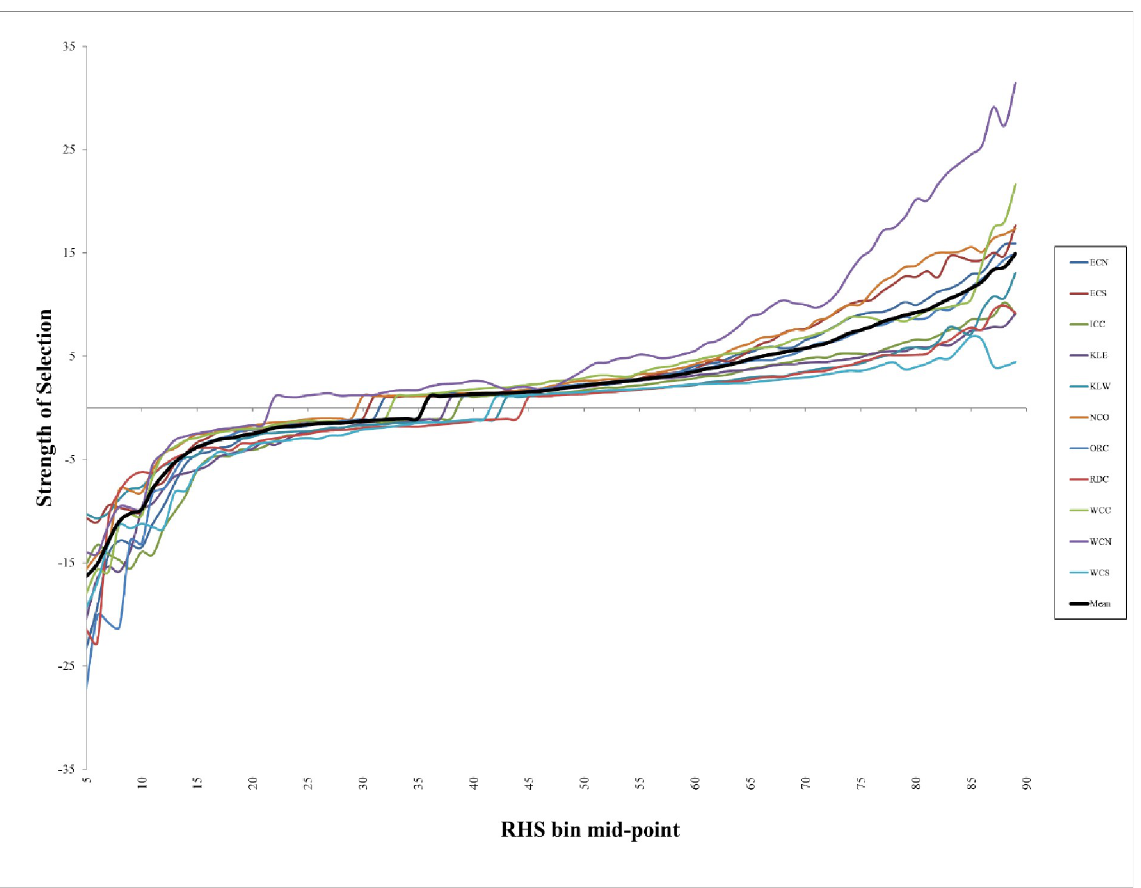
Fig 7. Northern Spotted Owl strength of selection (SOS) by relative habitat suitability (RHS) bin mid-point and modeling region. SOS is estimated by dividing the proportion of northern spotted owl site centers within a RHS bin by the proportion of the modeling region comprised of that bin (and thus represent relative densities of site centers). For values < 1, we divided the SOS value into -1 to allow values < 1 and > 1 the potential to vary to the same extent. Without doing this, values < 1 are constrained to be between 0 and 1, whereas values > 1 can grow nearly infinitely. Legend acronyms are the 11 modeling regions and the mean of all regions